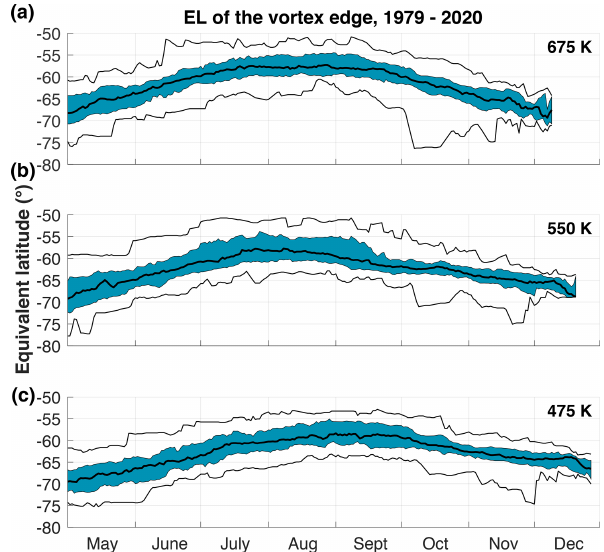
Figure 3. SC composites of the seasonal evolution of vortex edge intensity for the period 1979–2020, from (a) to (c) : 675, 550, and 475K. Red curves represent median values for maxSC years and blue curves for minSC years. Dark gray areas indicate values be- tween the 20th and 80th percentiles for maxSC years and light gray areas for minSC